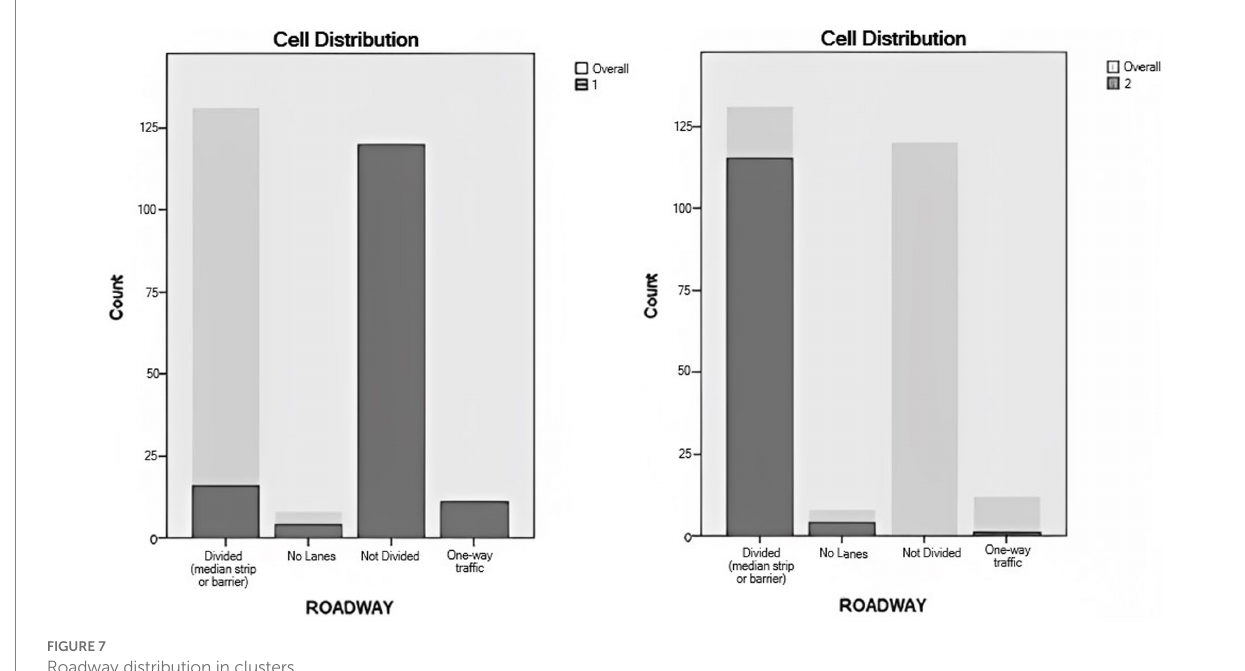
FIGURE 7 Roadway distribution in clusters.